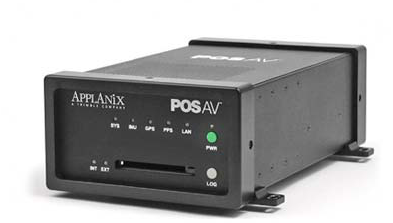
Figure 1. Applanix POS/AV (source: